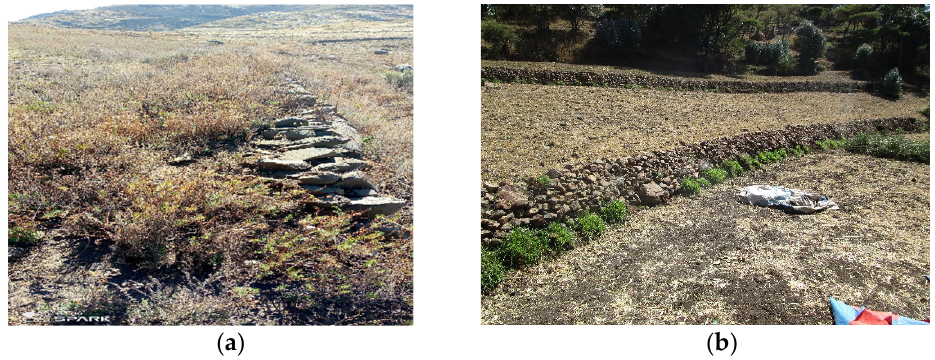
Figure 12. ( a ) Stone-faced bund covered with unpalatable plant species; and ( b ) broken and unmain- tained bund on-farm plot.